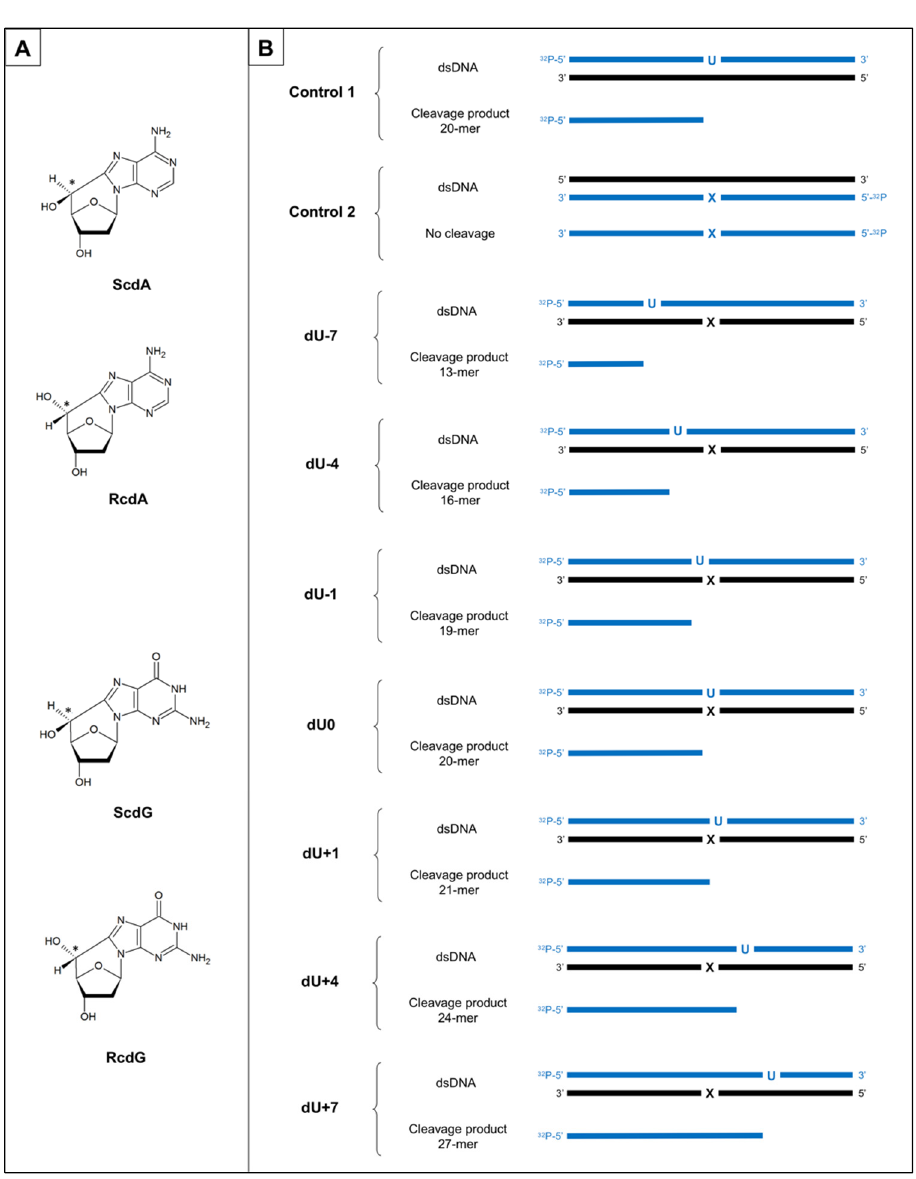
Figure 1. ( A ) The representation of chemical structures of the 5 ′ ,8-cyclo-2 ′ -deoxypurines (cdPus): (5 ′ S )-5 ′ ,8-cyclo-2 ′ -deoxyadenosine (ScdA), (5 ′ R )-5 ′ ,8-cyclo-2 ′ -deoxyadenosine (RcdA), (5 ′ S )-5 ′ ,8-cyclo- 2 ′ -deoxyguanosine (ScdG), (5 ′ R )-5 ′ ,8-cyclo-2 ′ -deoxyguanosine (RcdG); ( B ) The schematic presenta- tion of investigated ds-oligonucleotides (40 bp) with labeled ends, lesion positioning and cleavage products. U—represents location of an AP site obtained from 2 ′ -deoxyuridine (dU) after treatment with uracil DNA-glycosylase (UDG); X—represents location of the cdPu; 32 P—represents strand end labeled with [ γ - 32 P]ATP; blue color—represents radiolabeled strands of dsDNA and corresponding cleavage products subsequently observed on radiograms; negative numbers—dsDNA with clus- tered lesions on two strands where AP site is located 1–7 base pairs in 3 ′ direction; positive numbers —dsDNA with clustered lesions on two strands where AP site is located 1–7 base pairs in 5 ′ direc- tion.